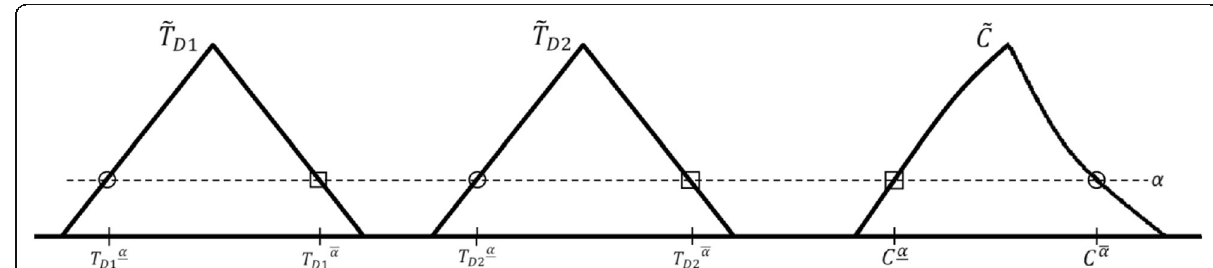
Fig. 2 Fuzzy capacity obtained from fuzzy Dwell